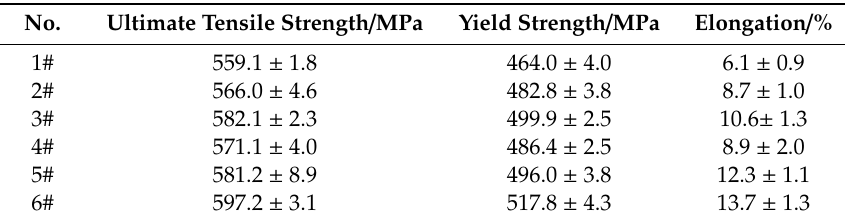
Table 5. Average results of static tensile test of all samples.